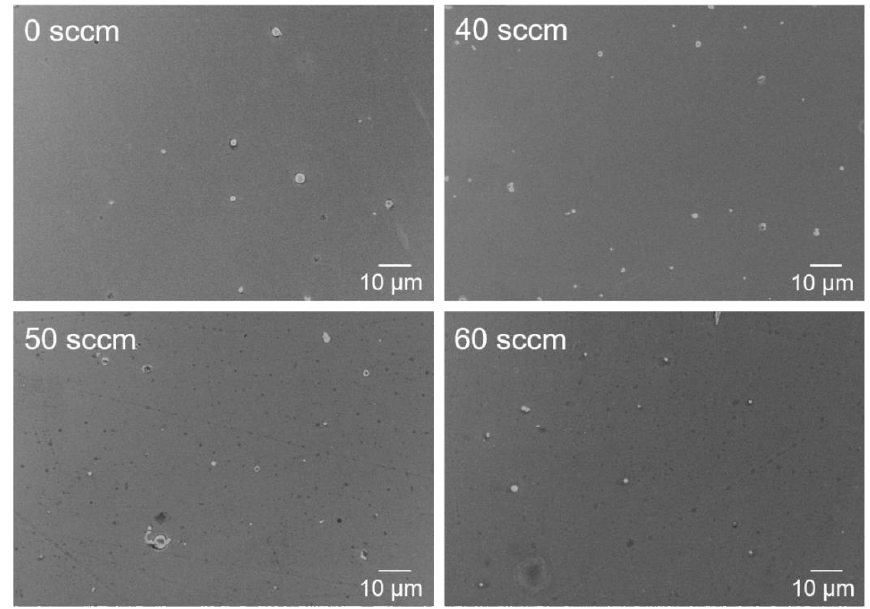
Figure 4. The surface of the TiAlN coatings prepared at different nitrogen flux rates.